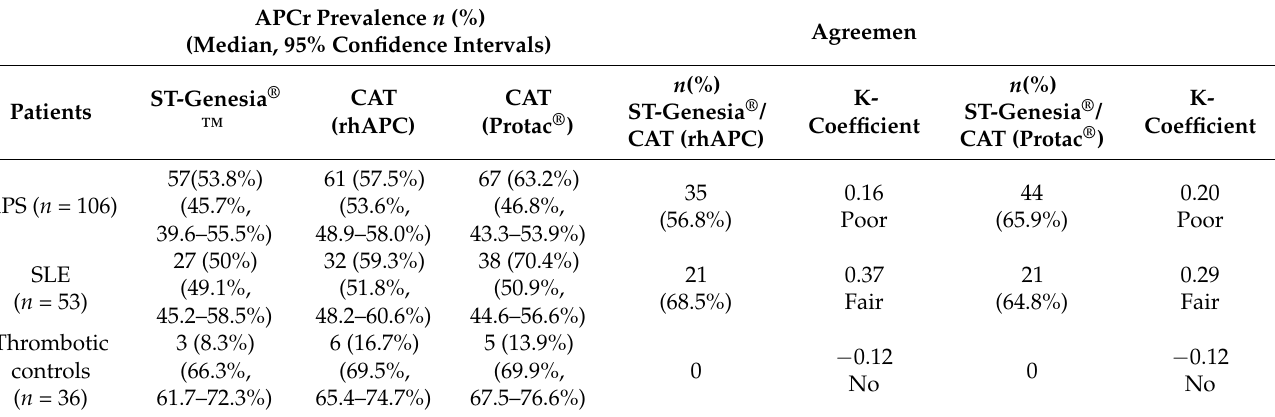
Figure 1. Scatter plot graph of activated protein C resistance (APCr) in APS, SLE patients and thrombotic controls: ( A ) ST-Genesia ® in the presence of thrombomodulin (TM); ( B ). CAT analyser in the presence of recombinant activated protein C (rhAPC) and ( C ). Protac ® . The horizontal broken line indicates the ninety-ninth centile of NC for each method. Median values in each patient group are indicated. APS patients include thrombotic and pregnancy morbidity (PM), and SLE patients include both thrombotic and non-thrombotic. Patients on warfarin anticoagulation are represented with an open circle symbol ( ), and patients on no anticoagulation treatment with an inverted triangle ( (cid:53) ). (cid:35) Table 1. APCr prevalence and categorical agreement between ST-Genesia ® and the CAT analyser in APS, SLE, and thrombotic control